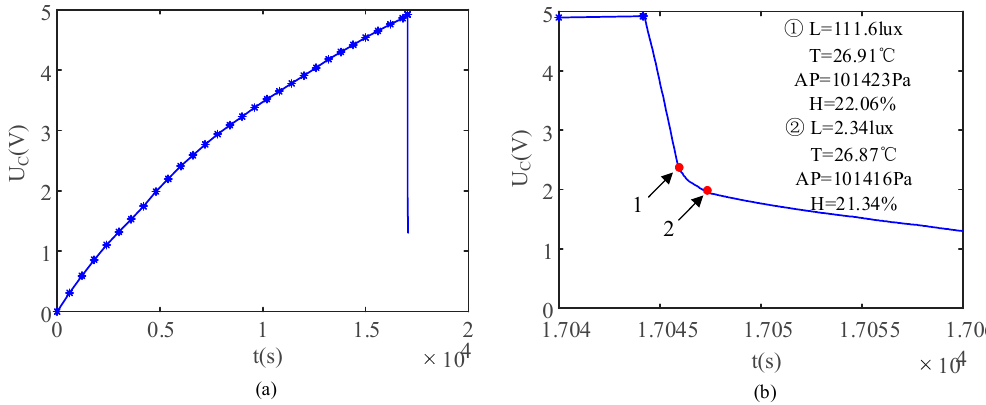
Figure 10. Voltage variations in the energy storage capacitor in ( a ) the charging process and ( b ) discharging process.